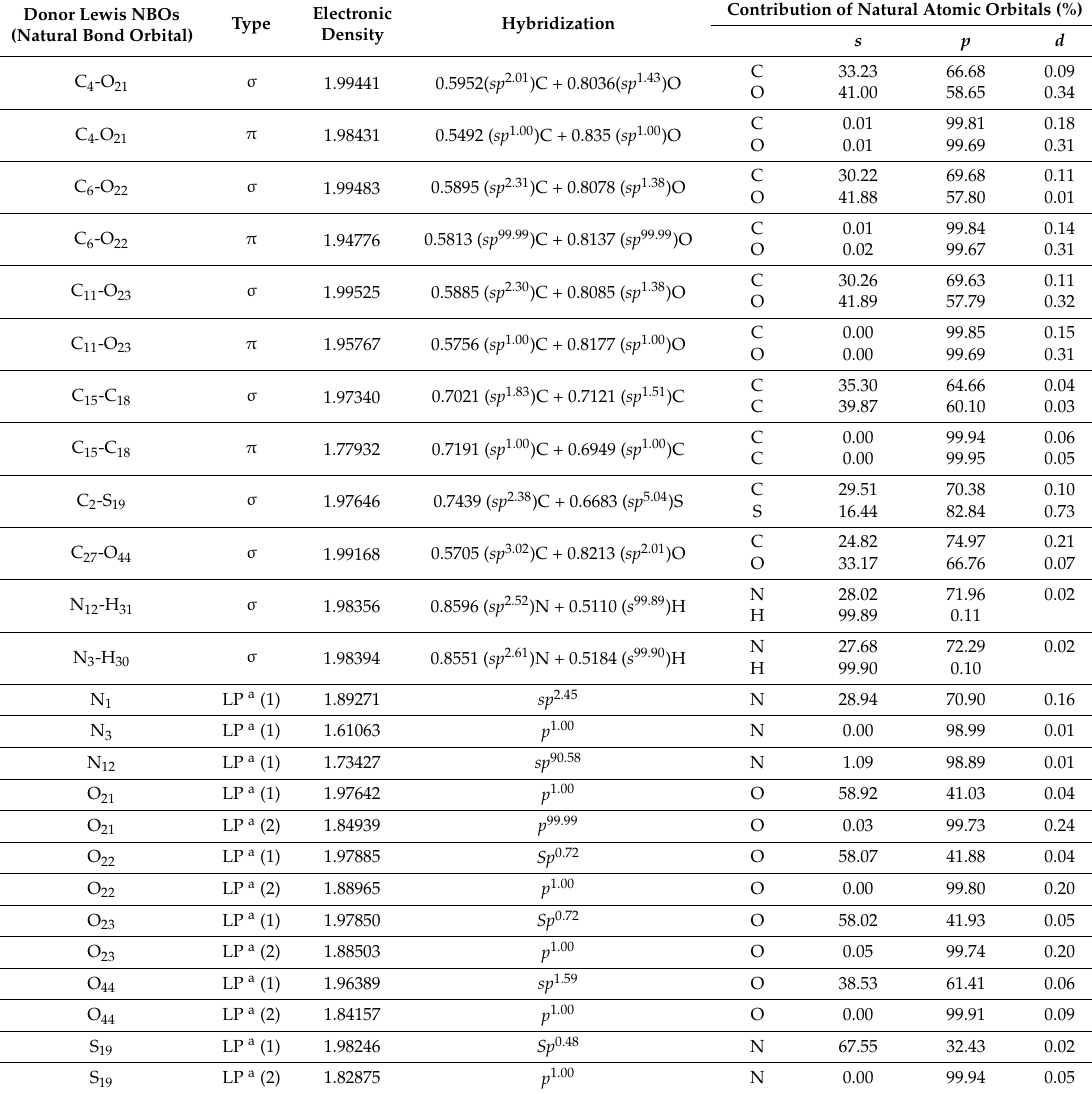
Table 5. Occupation of natural orbitals and hybrids for 4c calculated by the DFT/B-3LYP/6-31G(d,p) method for the representative